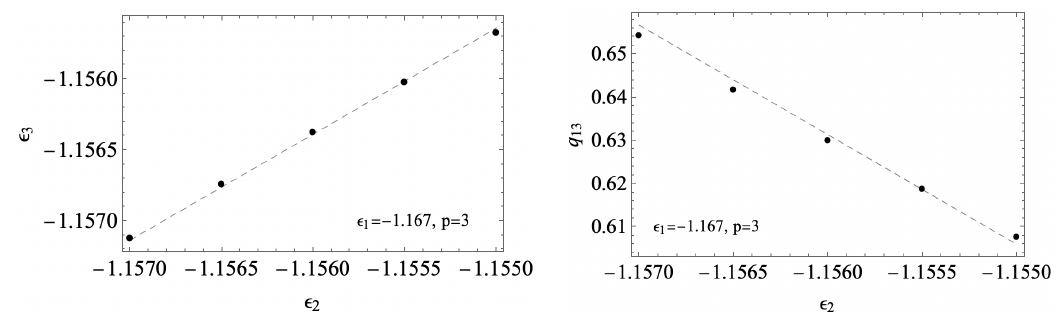
Figure 6: Asymptotic overlap ( Left. ) and energy ( Right. ) of the minima s reached 3 from the zero-complexity saddles at energy ε that are closer to the reference mini- 2 ( ε ) ). The dashed line are linear fits. mum ( i.e. , that are at overlap q M 2 In Fig. 6 we focus on the closest saddles to the minimum for each ε (i.e., on those at 2 ( ε ) with the minimum, having zero complexity), and plot the asymptotic en- overlap q M 2 ergy and overlaps reached from these saddles, which show an almost linear dependence on ε . We see that moving along the curve corresponding to zero complexity of the sad- 2 dles, the ones having lower energy lead to lower energy minima, but that are at larger overlap with the original minimum. Thus, there is a competition between energy and overlap of the asymptotic states: the saddles leading to lowest energies are not those leading to the farthest stationary